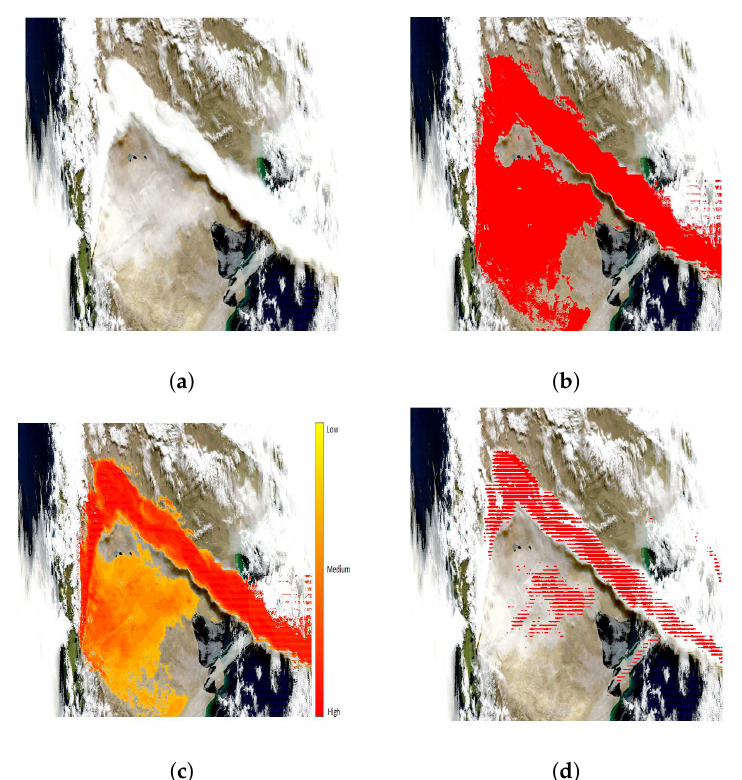
Figure 7. Result comparison from the Puyehue-Cordon Caulle eruption, Chile, 2011. ( a ) Composed RGB MODIS image during the event. ( b ) Detection of volcanic ash cloud based on spectral retrieval. ( c ) Ash cloud monitoring and relative concentration. ( d ) Temperature difference method